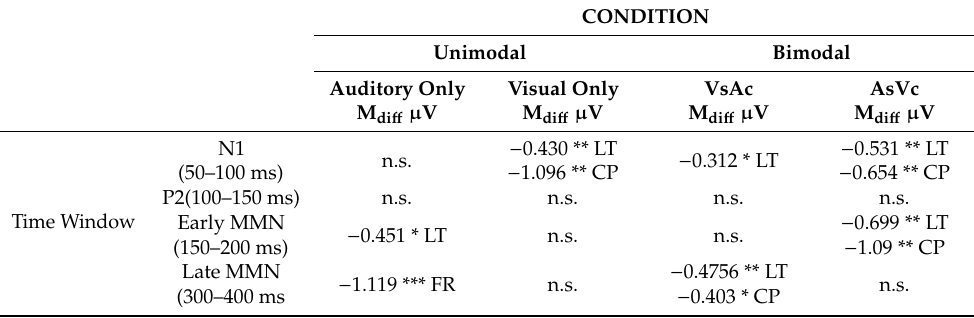
Table2. Summaryofsignificantevent-relatedpotential(ERP)e ff ectswheredeviantismorenegativethan standard by condition and time window (stimulus type and montage specified by cell). M di ff = mean di ff erence between deviant and standard; VsAc = Visual steady, Auditory change; AsVc = Auditory steady, Visual change; FR = frontal montage; LT = left temporal montage; CP = central parietal montage. * p < 0.05, ** p < 0.01, *** p <